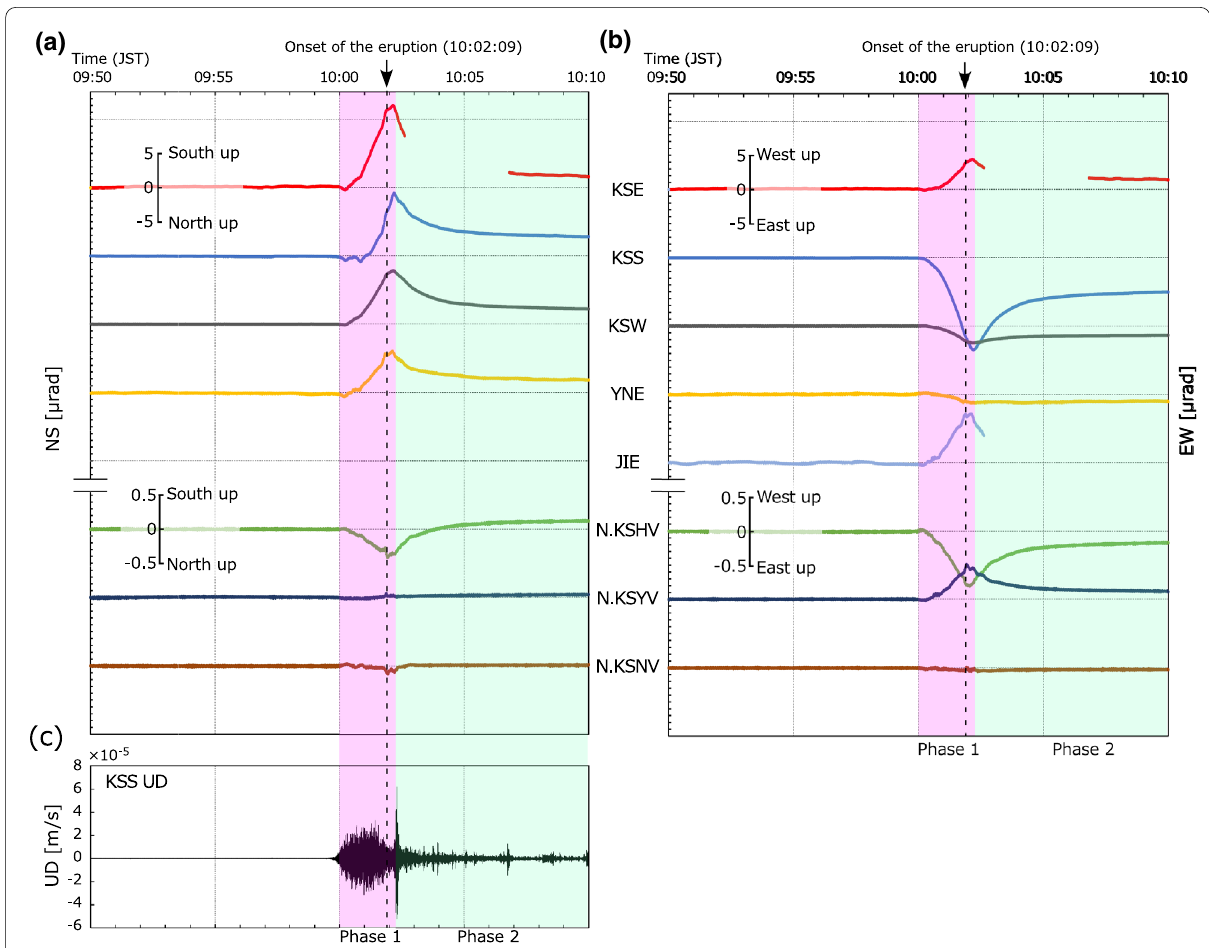
Fig. 3 Tilt components recorded at 09:50–10:10 (JST) on 23 January 2018. a North–south and b east west components. Acausal low-pass filters with cut-off frequencies of 0.034 and 0.021 Hz were applied to the tilt records of JTS-33 (KSE, KSS, KSW, N.KSHV, N.KSYV, and N.KSNV) and 701-2A (YNW and JIE), respectively. c Raw vertical ground velocity waveform at KSS. See Fig. 1 and Table 1 for station names and locations. We term the inflation and deflation phases as phase 1 and phase 2, respectively. The time of eruption onset was estimated by Yamada et al.